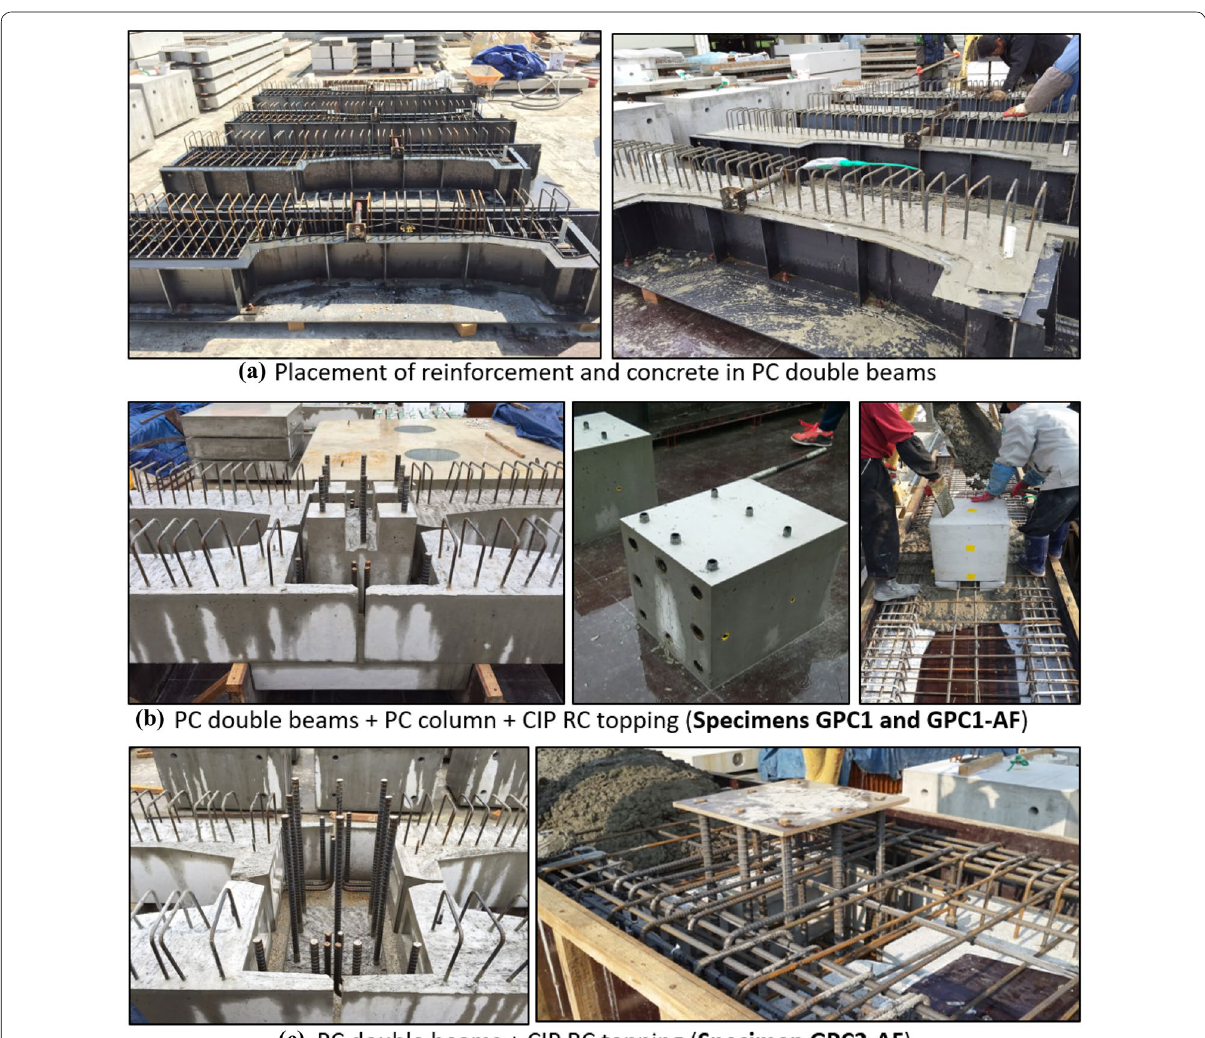
Fig. 8 Construction of test specimen under gravity